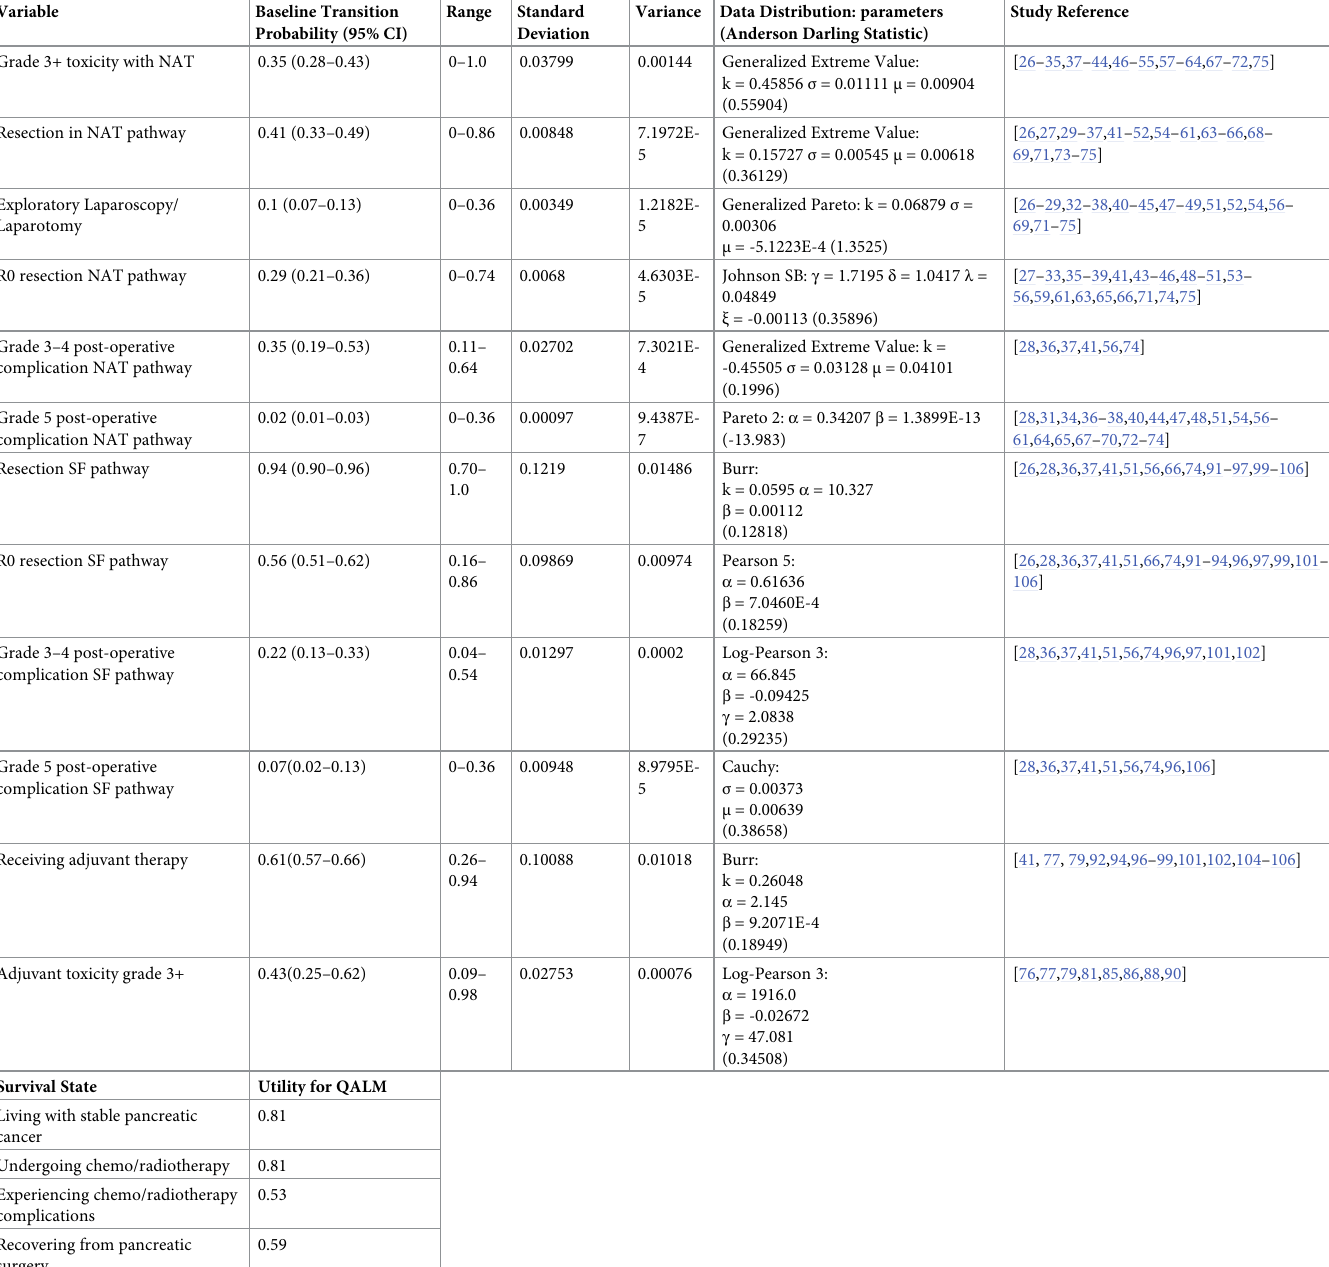
Table 2. Summary of transition probabilities, parameters of data distribution and payoff utilities for quality adjusted life months (QALMs).